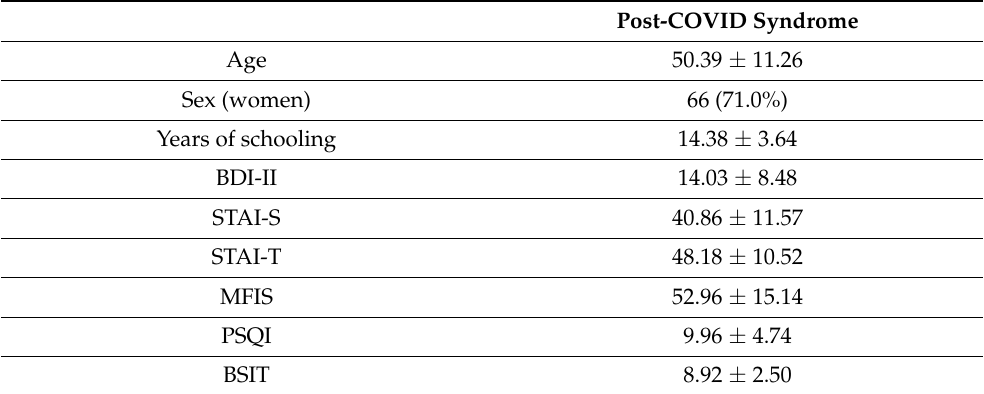
Table 1. Main clinical and demographic characteristics of our sample of patients with post-COVID